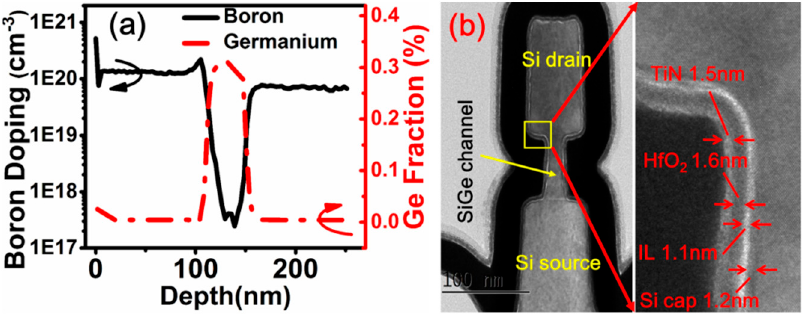
Figure 8. ( a ) Secondary ion mass spectrometry (SIMS) profiles of B and Ge in a p-Si/i-SiGe/p-Si sandwich film [31]. An abrupt B profile was achieved by in-situ doped epitaxial growth. ( b ) TEM cross-sections of an NS pVSAFET with an Si cap and an HKMG stack with interface layer (IL) = 1.1 nm [46].